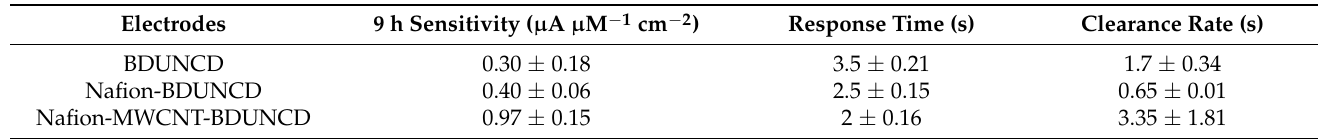
Table 2. Comparison of DA sensitivity, response time, and clearance rate during 9 h on the BDUNCD, nafion-modified BDUNCD, and nafion–MWCNT-modified BDUNCD electrodes ( n = 3).